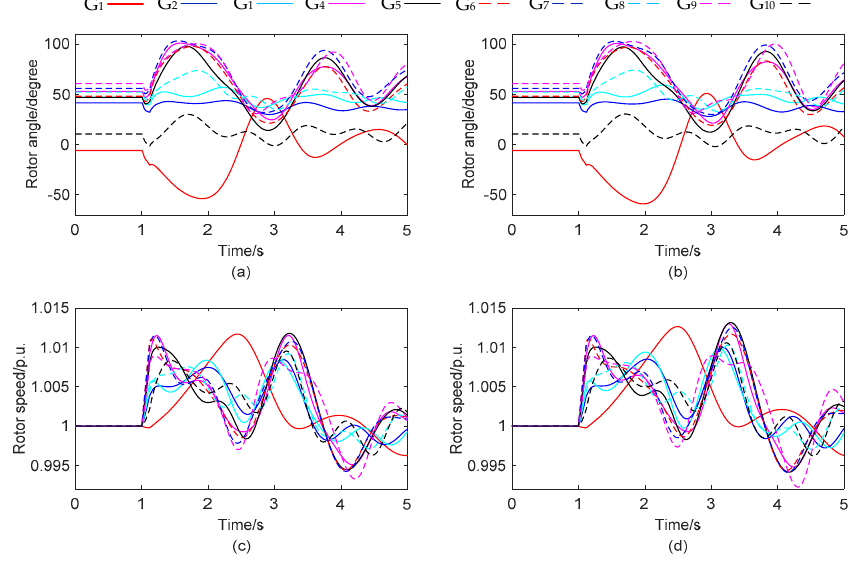
Figure 12. Dynamics of generator ( a ) rotor angle; ( c ) rotor speed with 100 ms delay; dynamics of generator ( b ) rotor angle; ( d ) rotor speed with 200 ms delay.